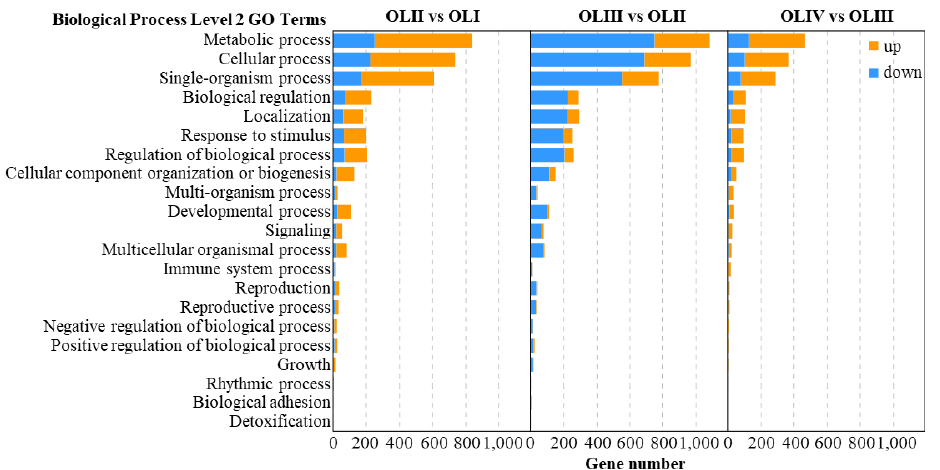
Figure 3. GO functional of the significantly differentially expressed genes of old leaves in diverse pairwise comparisons.